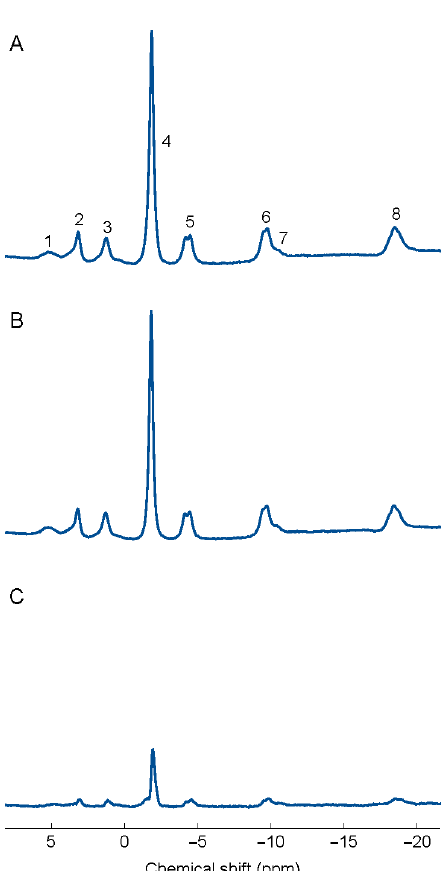
Figure 2. Spectra corresponding to the mean for the ( A ) control group ( n = 30) and the corresponding ( B ) patient group with fibromyalgia ( n = 32) in the spinal erectors at 3 T. Spectra are all normalized in Table (1) Phosphomonoesters(PME), (2) inorganic phosphate (Pi), (3) phosphodiesters (PDE), (4) phosphocreatine (PCr), (568) γ , α , and β -nucleotide triphosphate (mainly Mg-saturated ATP), and (7) NAD(H). ( C ) The difference between the two groups of subjects.